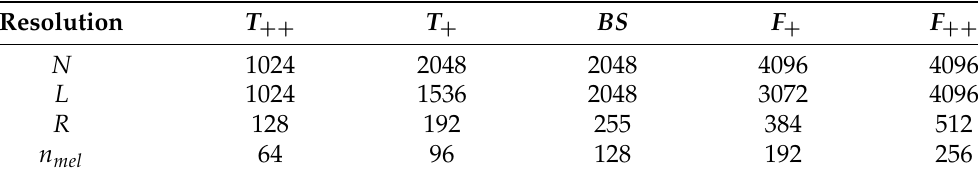
Table 3. FFT length ( N ), window length ( L ), window hop ( R ), and number of Mel filters ( n mel ) of five proposed time-frequency resolution working points. N , L , and R are reported in samples, using a sample rate f s = 16,000